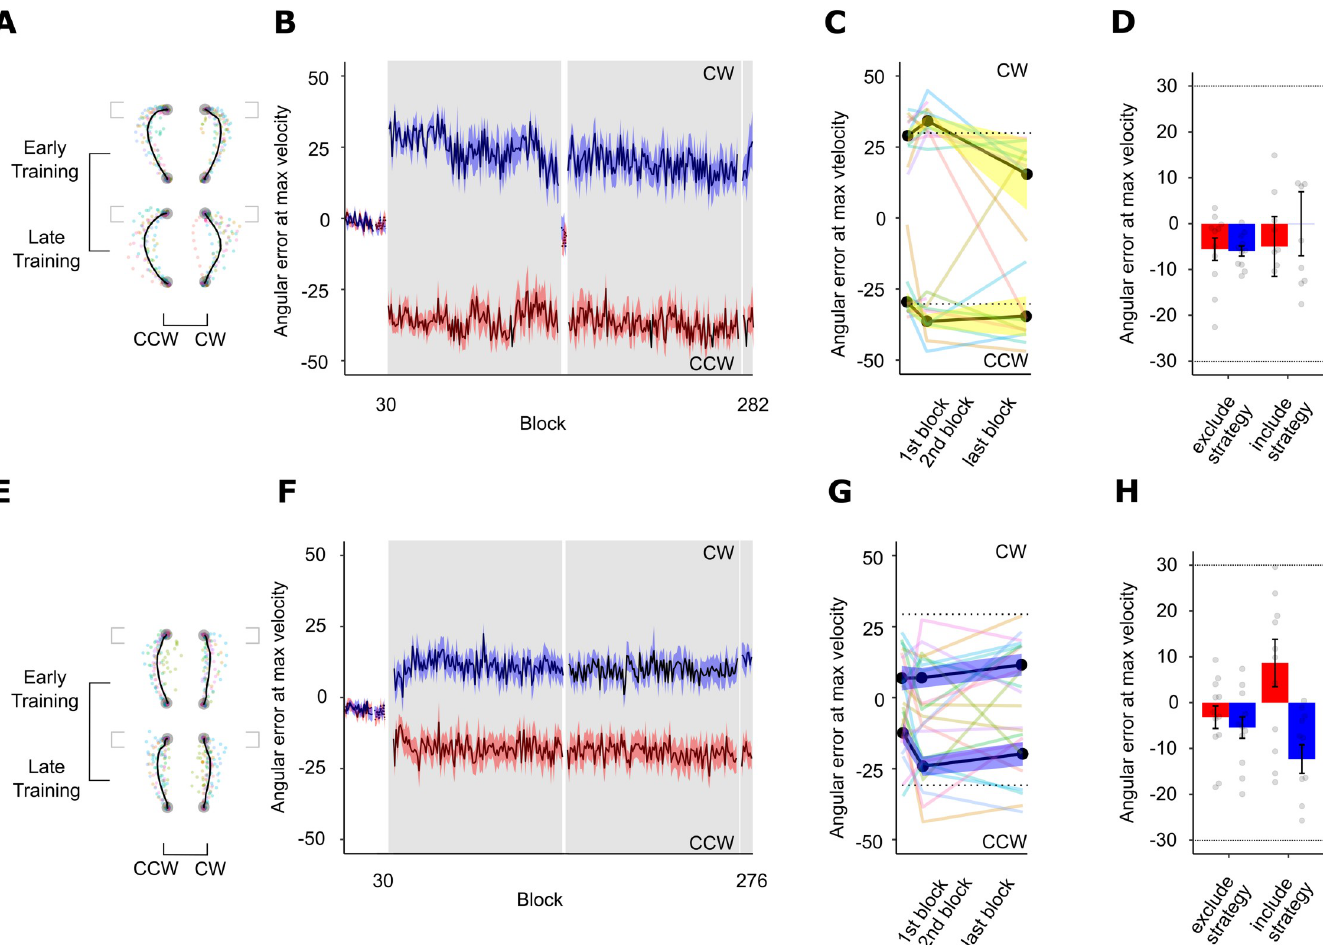
Fig 6. Experiment 2 performance. A. Averaged hand-cursor trajectories for the Non-instructed group. Coloured translucent dots represent individual trajectories. B. Visuomotor adaptation across training blocks for the Non-instructed group. The learning curve for CW trials is in blue, and CCW trials in red. C. Truncated visuomotor adaptation across training for the Non-instructed group. Colored translucent lines represent individual learning curves. D. Reach aftereffects in post- training for the Non-instructed group. Grey dots represent individual participant errors. Red bars represent CW errors and blue bars represent CCW errors. Dashed lines represent rotation magnitude experienced during training (30˚ CW and 30˚ CCW). Dashed lines represent the rotation magnitude. Error bars represent SEM. E. Averaged hand-cursor trajectories for the Instructed group. F. Visuomotor adaptation across training blocks for the Instructed group. G. Truncated visuomotor adaptation across training for the Instructed group. H. Reach aftereffects in post-training for the Instructed group.